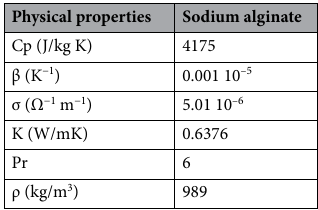
Table 1. Sodium alginate